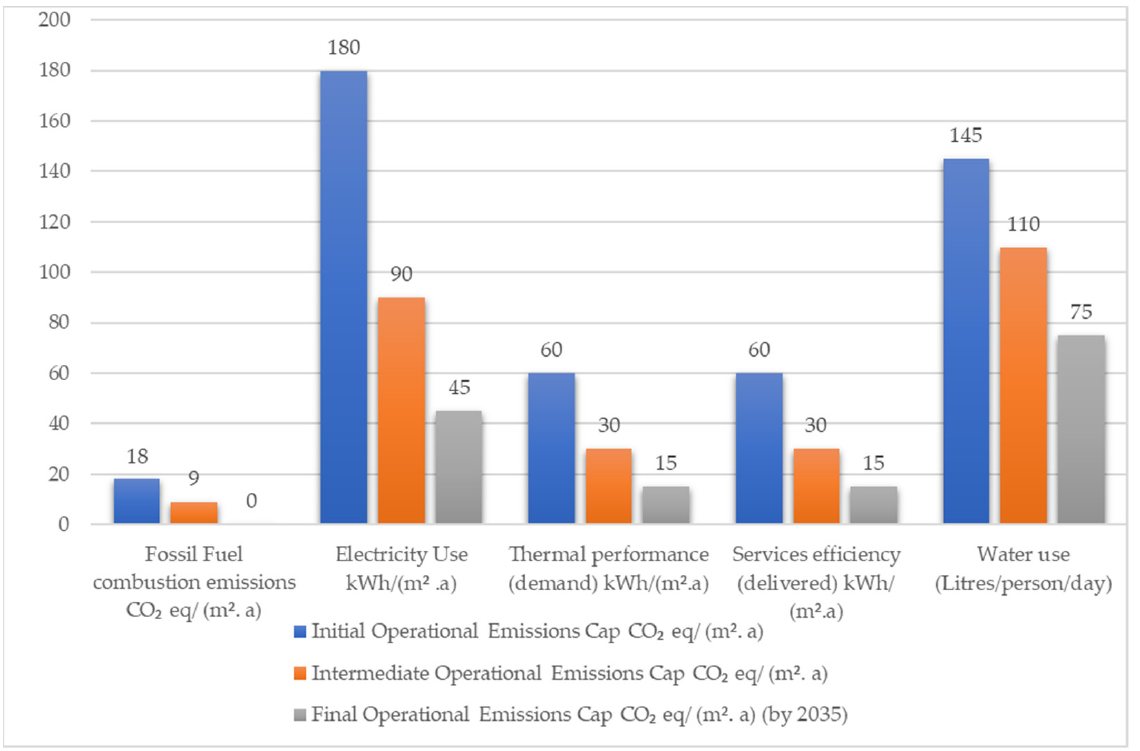
Figure 2. Operational Emissions Cap goals for the New Zealand building sector by 2035 (Source: [7] ).